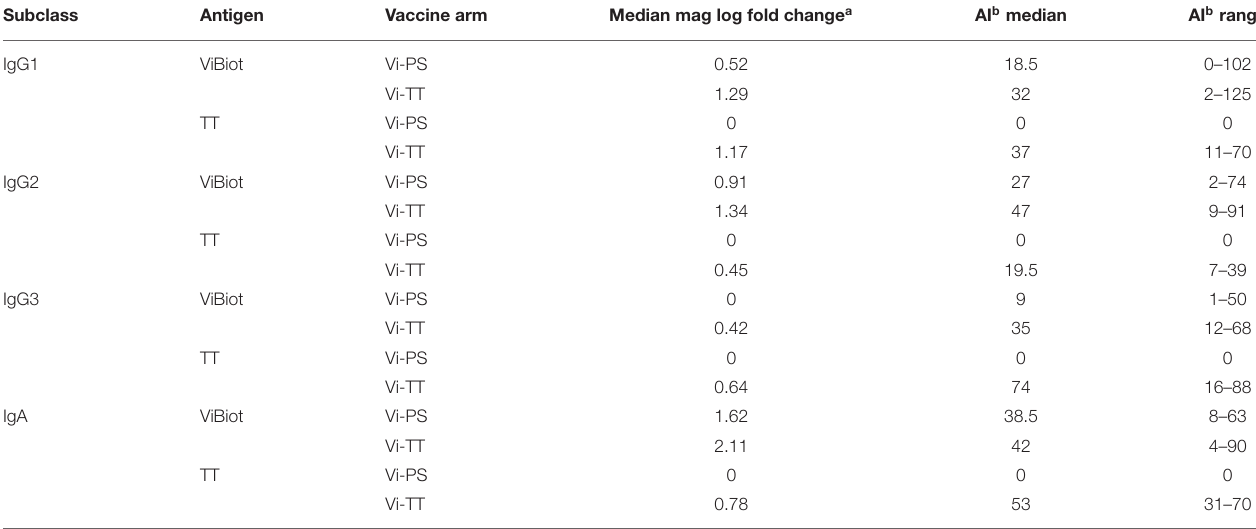
TABLE 1B | Antigen-Specific Responses by Vaccine Group at Day of Challenge (D0).